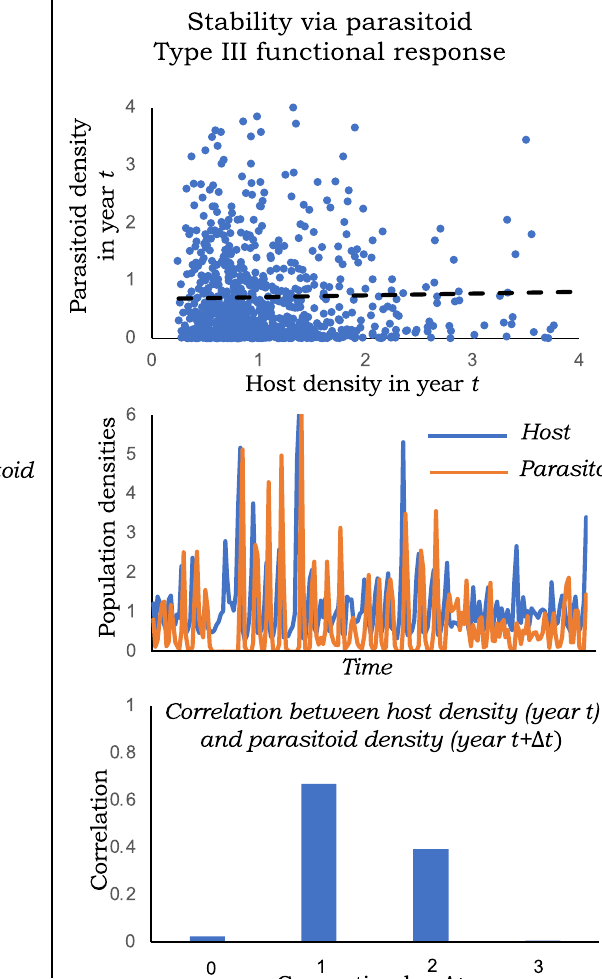
decays back to zero with increasing generation lag (cid:31) t